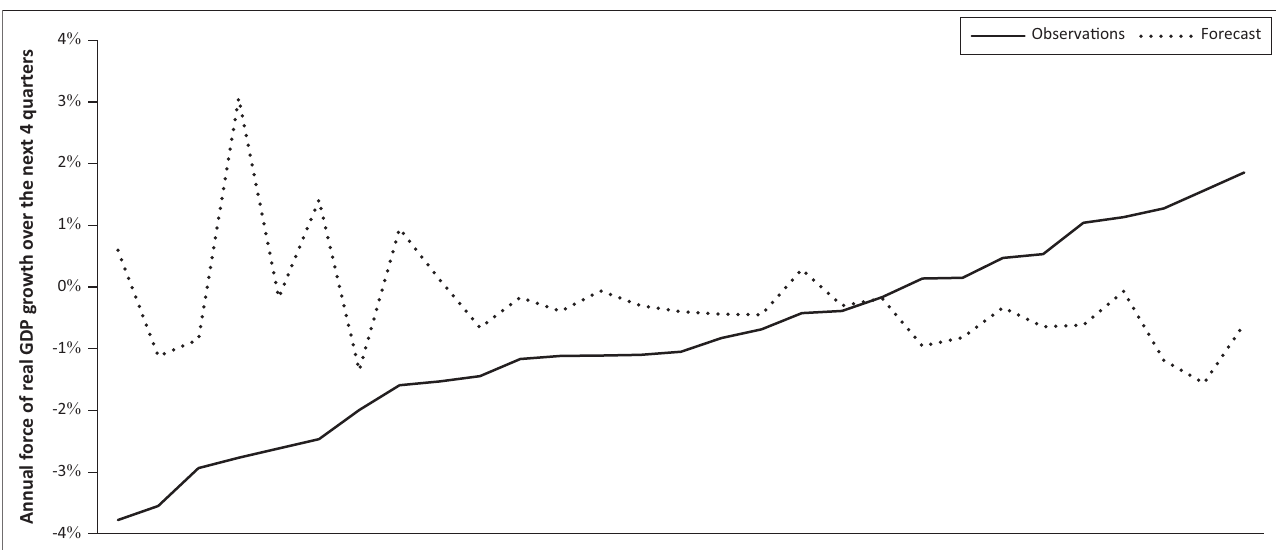
FIGURE 5: Plot of ordered observations of annual forces of real GDP growth over a four quarter ahead period during downwards business